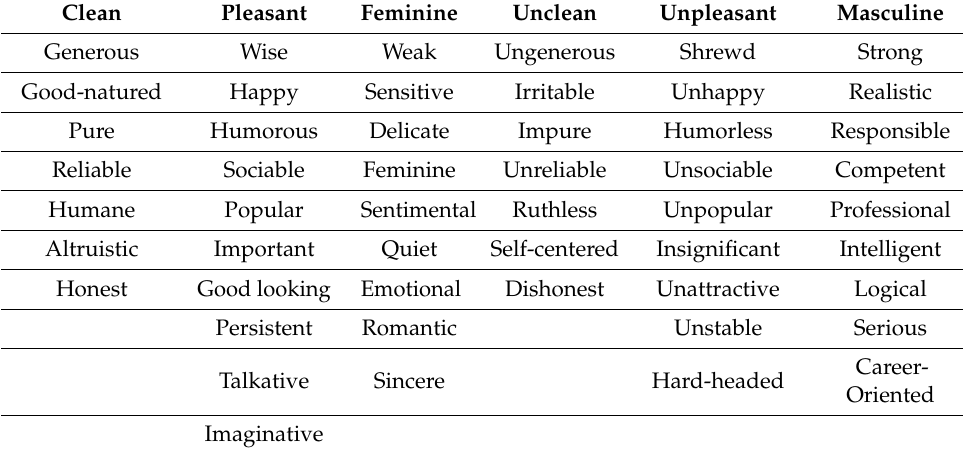
Table 1. 51 Personality traits used for ratings of a hypothetical person. The traits are listed in the six categories (attributes) determined a priori by the researchers; traits were presented randomly without regard to attribute to each participant during the